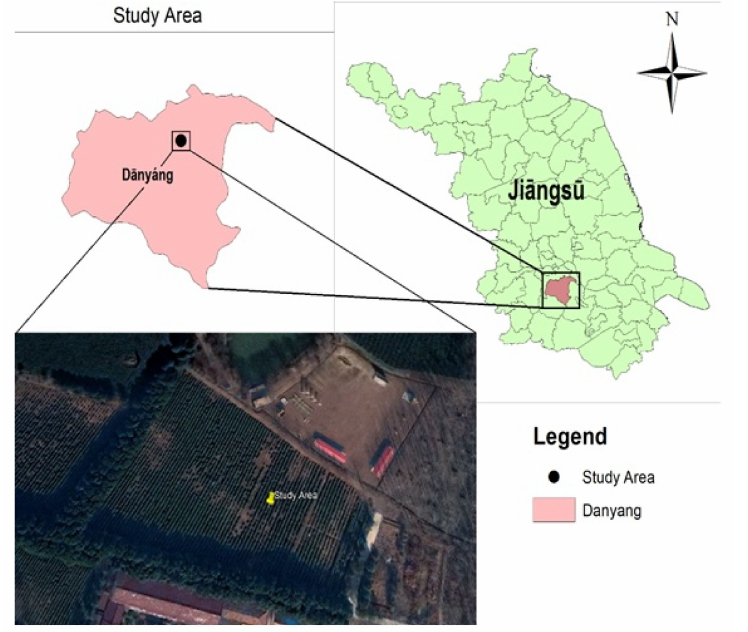
Figure 1. The study area: a map of Jiangsu province ( top right ), Danyang district ( top left ) and an aerial view of the study site ( bottom